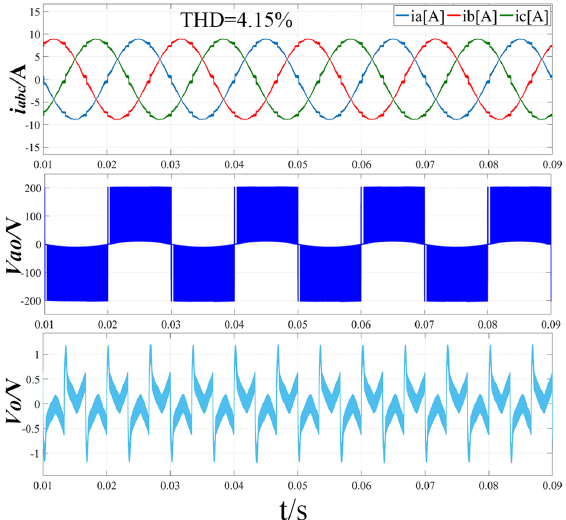
Figure 11. Simulation results of three-phase input current, line-to-neutral voltage and midpoint potential difference with traditional modulation strategy (m = 0.51, Vdc = 400 V).